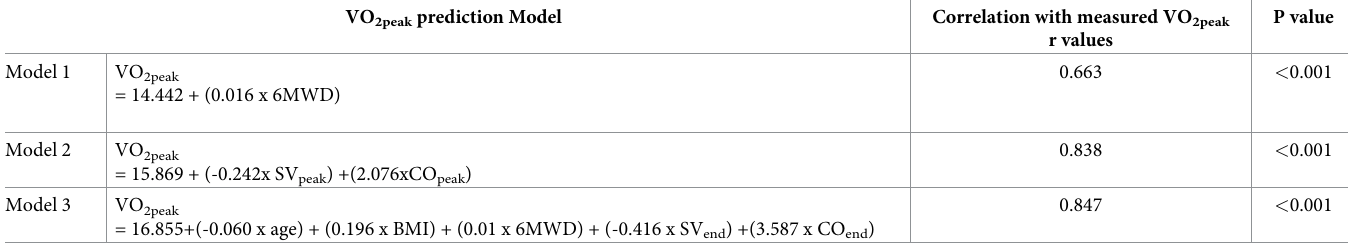
Table 5. Correlation between measured and predicted VO 2peak generated by different equation models. VO 2peak prediction